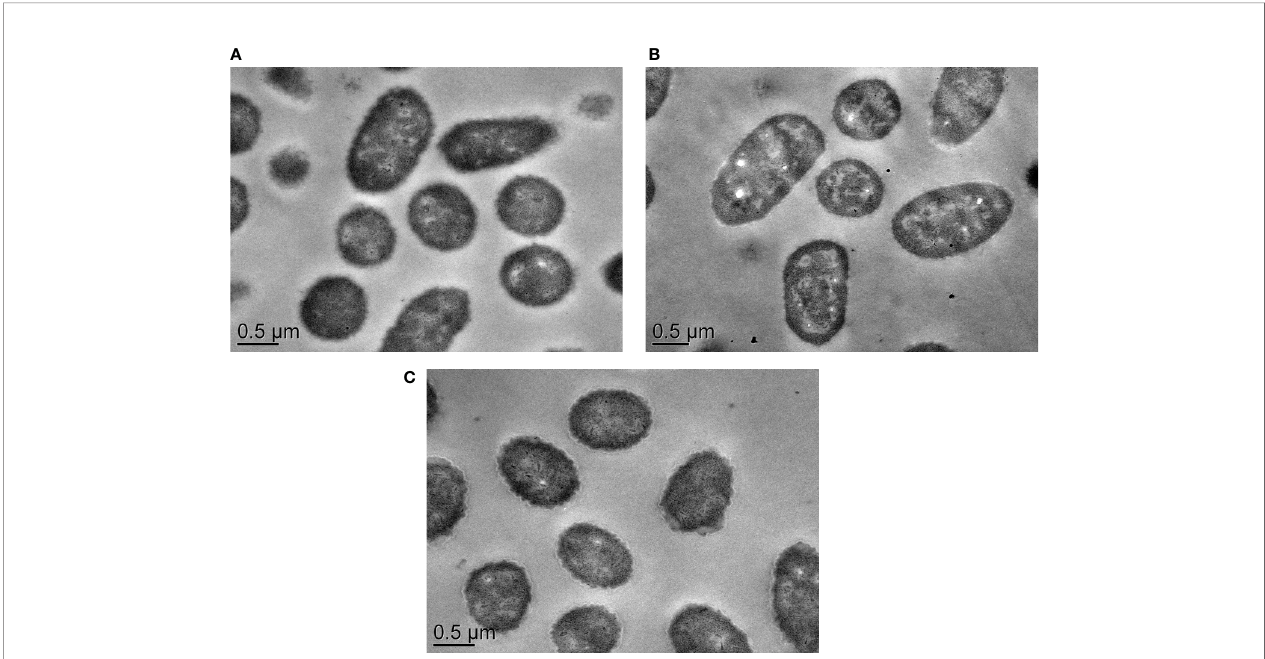
FIGURE 8 | The TEM observation of cell structure of V. parahaemolyticus CHN25, D VpaChn25_0724 , and D VpaChn25_0724-com strains. (A) Wild type; (B) D VpaChn25_0724 ; (C) D VpaChn25_0724